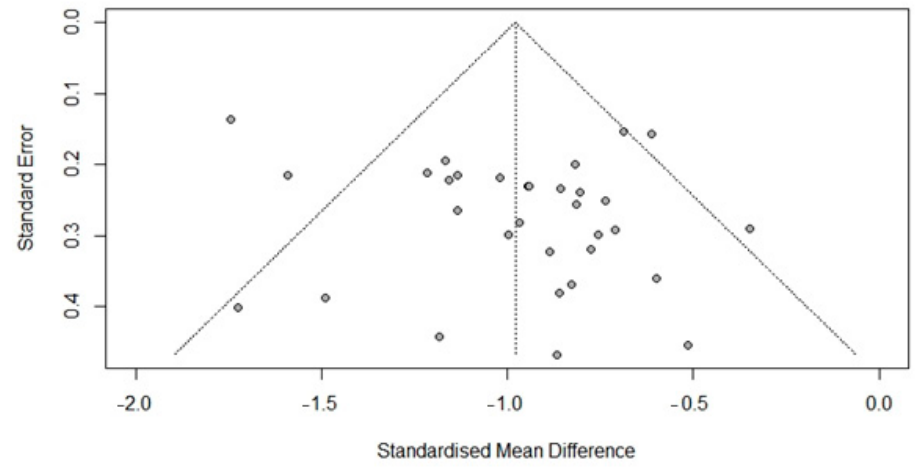
Figure 4. Funnel plot of full-scale intelligence scores in the DMD population.